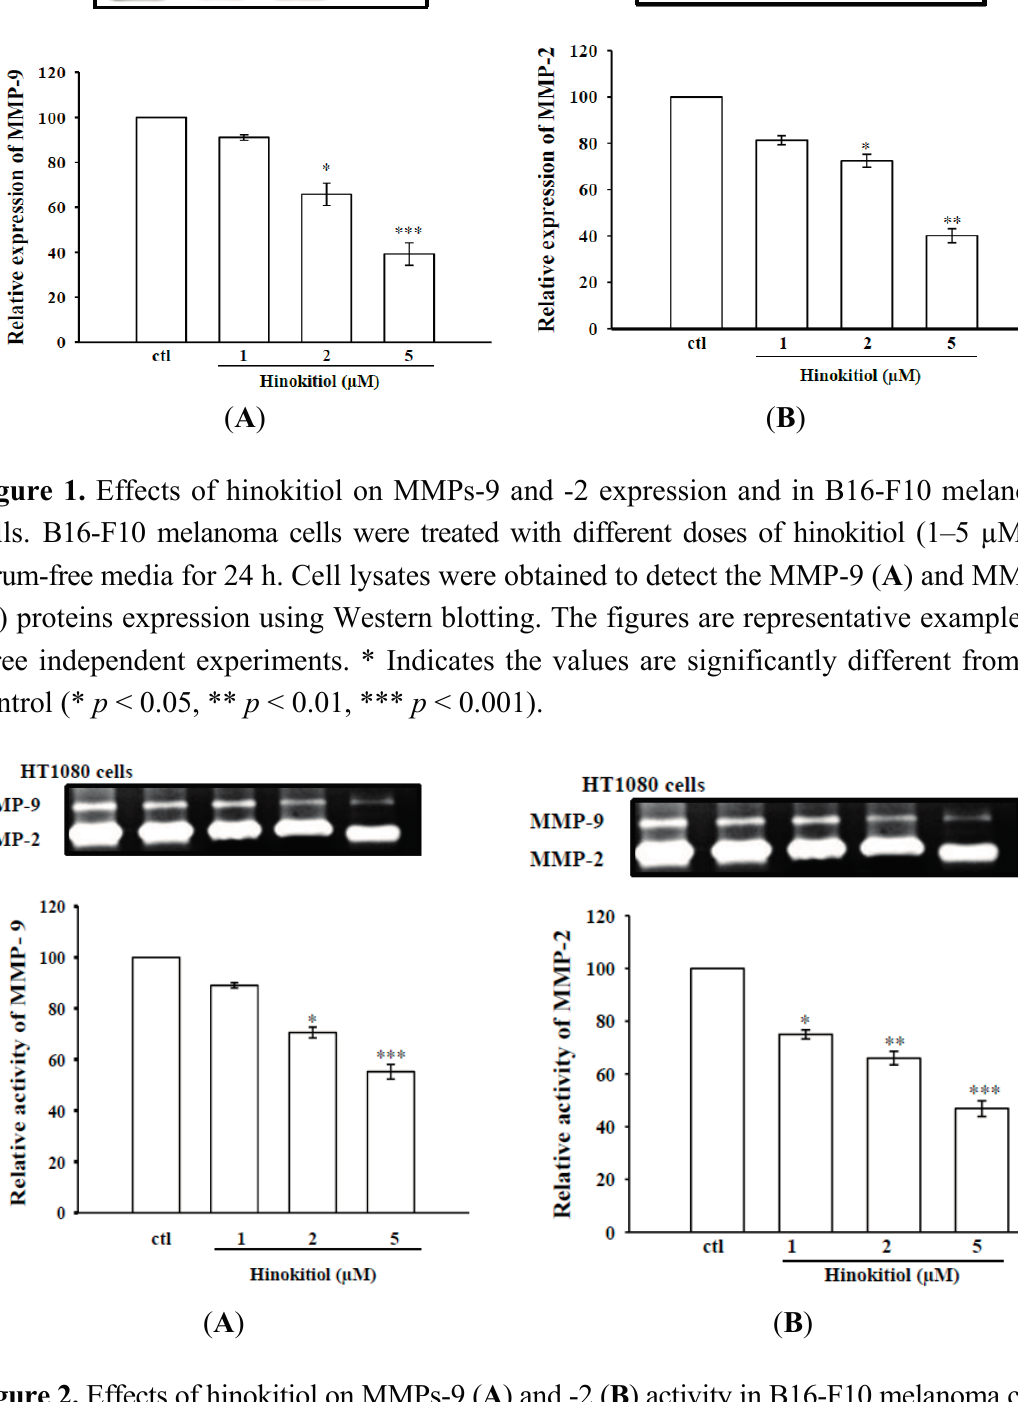
Figure 2. Effects of hinokitiol on MMPs-9 ( A ) and -2 ( B ) activity in B16-F10 melanoma cells. B16-F10 melanoma cells were treated with different doses of hinokitiol (1–5 µM) in serum-free media for 24 h. After treatment periods, media were collected for the assay of MMPs activity using gelatin zymography. The culture medium of HT1080 cells (the constitutive proMMP-2 and proMMP-9 were expressed) were used as control. The figures are representative examples of three independent experiments. * Indicates the values are significantly different from the control (* p < 0.05, ** p < 0.01, *** p <